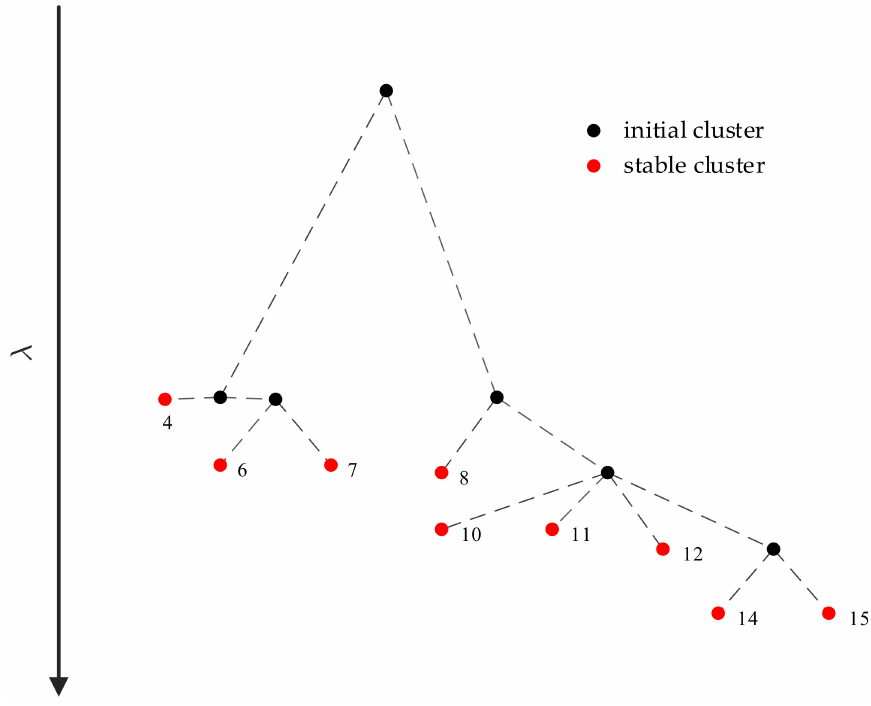
Figure 6. The schematic diagram of the condensed cluster tree for the matrix I .